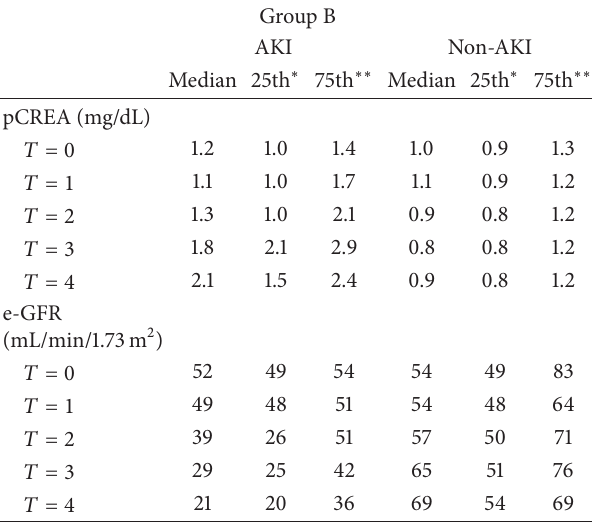
Table 2: Median, 25th, and 75th percentiles of plasma NGAl (pNGAL), urinary NGAL (uNGAL), plasma creatinine (pCrea),and e-GFR in Group A patients with and without AKI diagnosis.